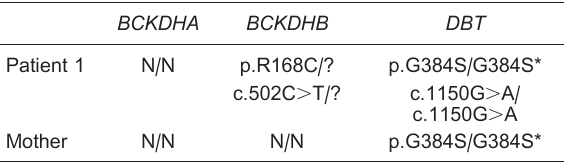
Table 1. Sequencing of the genes BCKDHA , BCKDHB , and DBT